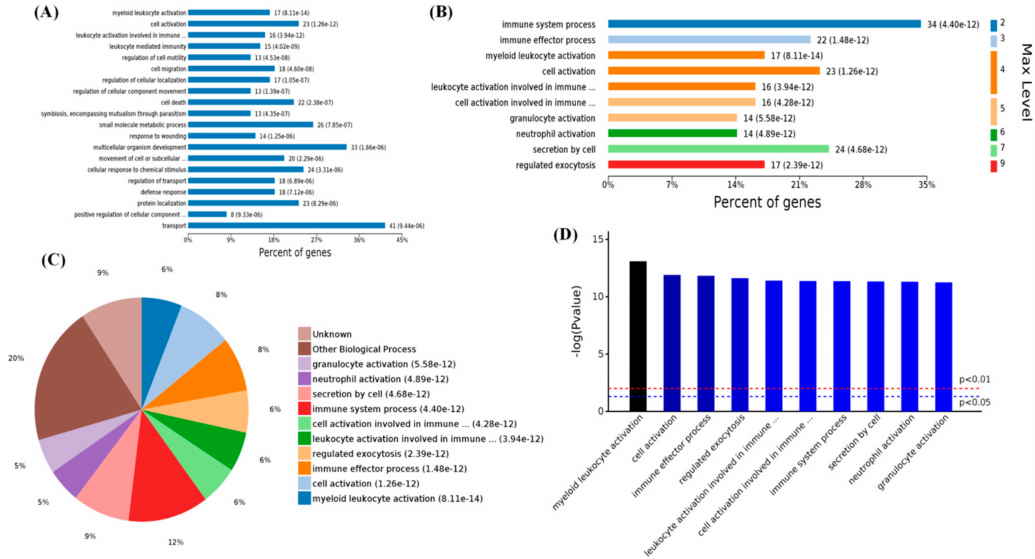
Figure 3. Enriched biological processes of 119 differential proteins in high-melatonin groups. ( A ) Levels of enriched biological processes; ( B ) significantly enriched biological processes (top 10); ( C ) expressed proteins of enriched biological processes; ( D ) significantly enriched biological processes with p